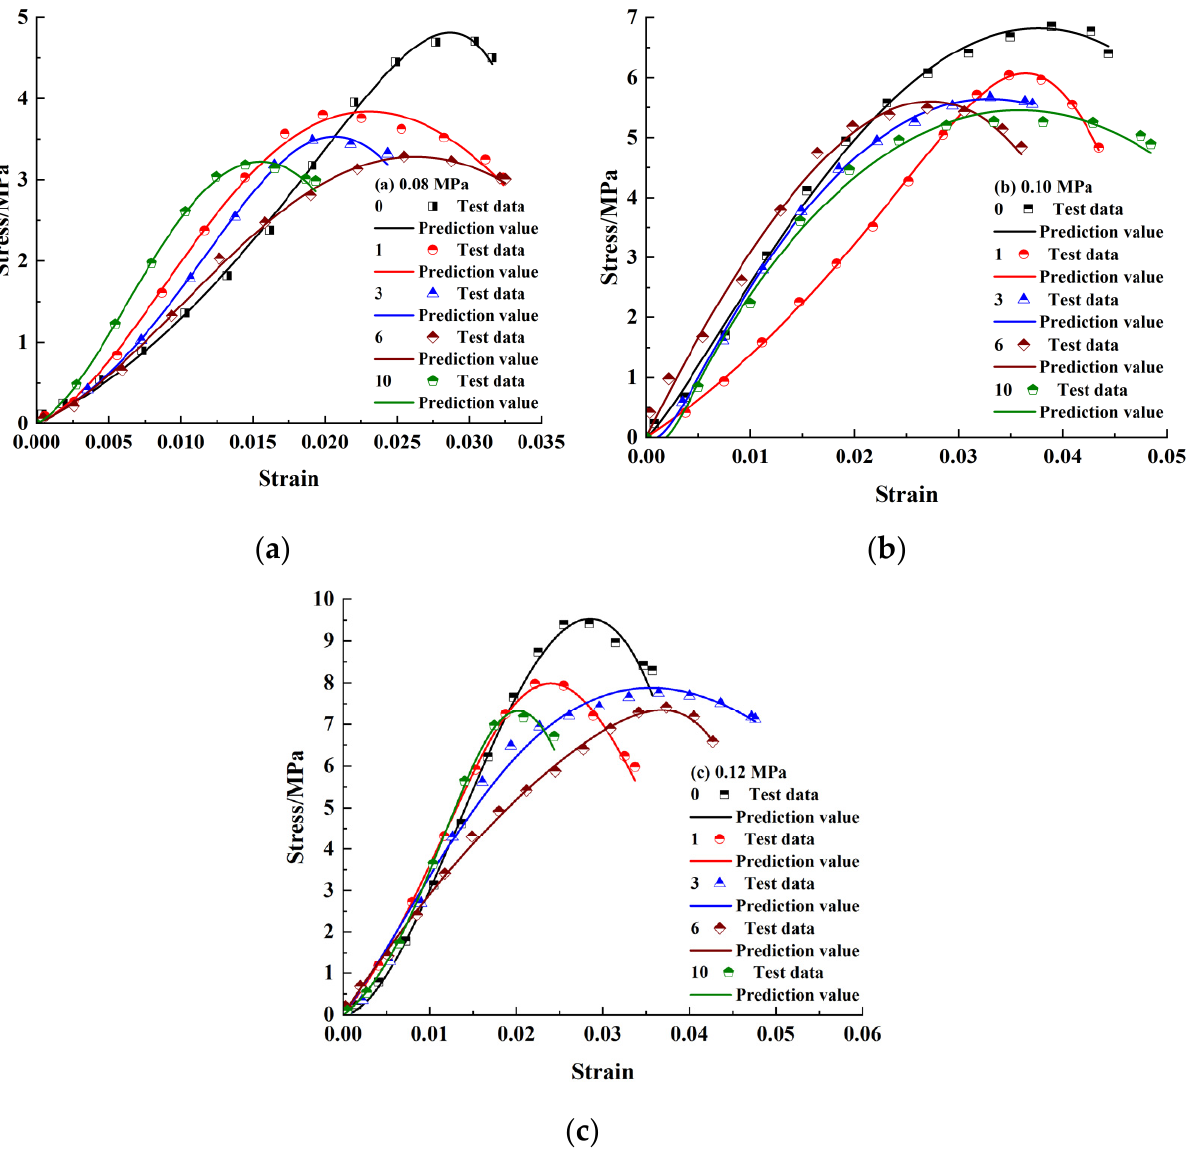
Figure 18. Comparison of theoretical and test results: ( a ) 0.08 MPa; ( b ) 0.10 MPa; ( c ) 0.12 MPa. Relative error was applied to quantitatively measure the applicability of the developed model, as stated in Equation (20): Table 6. Fitting parameters of cement clay. σ test − σ pre δ = σ pre where σ test and σ pre are the test and predicted values, respectively, (MPa). As shown in Figure 19, the developed model had a high prediction accuracy and the relative errors obtained for 0.08, 0.10 and 0.12 MPa were in the ranges of − 4.46~4.40%, − 4.95~6.42% and − 6.11~6.61%, respectively. This indicated that the modified ZWT model accurately reflected the deformation and strength of cement soil under impact